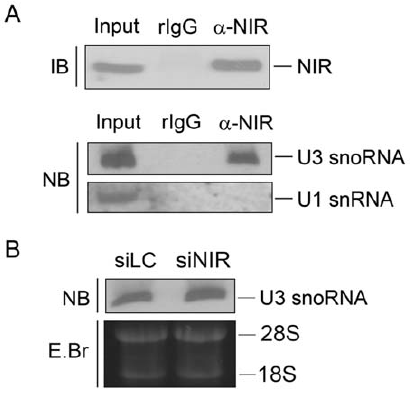
Figure 5. NIR was associated with U3 snoRNA invivo and knock down of NIR didn’t affect U3 snoRNA level. A. Immunoprecipi- tation was performed with anti-NIR antibody and whole cell lysates from U2OS cells. Proteins from NIR immunoprecipitates were separated on a SDS-PAGE and blotted onto a PVDF membrane. Blot was probed with anti-NIR antibody. Ten percent of the lysates were loaded as input control (upper panel). RNA was extracted from the above immunopre- cipitation, resolved on a 7% polyacrylamide–8.3 M urea gel and blotted onto a nylon membrane. The blot was probed with biotin-labeled U3 snoRNA-specific probe or U1-specific RNA probe (lower panel). B. U2OS cells were transfected with NIR specific siRNA (siNIR) or a siRNA targeting luciferase (siLC) as a control. Seventy-two hours post transfection, total RNA was extracted. Equal amount RNA was resolved on a 7% polyacrylamide–8.3 M urea gel and transferred onto a nylon membrane. Blot was hybridized with U3 snoRNA specific probe.